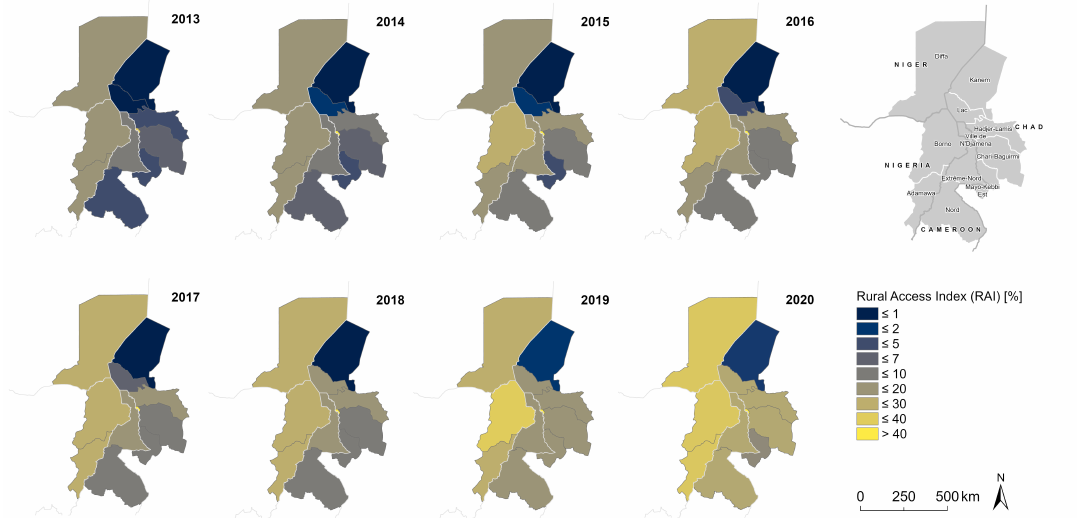
Figure 3. RAI between 2013 and 2020 on admin-1 level (data source: Global Administrative Areas, 2012)